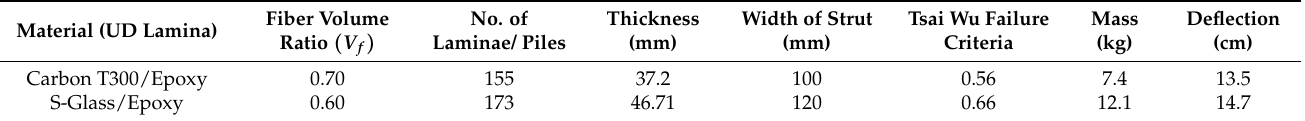
Table 11. Results of the landing gear assembly analysis under two point landing load